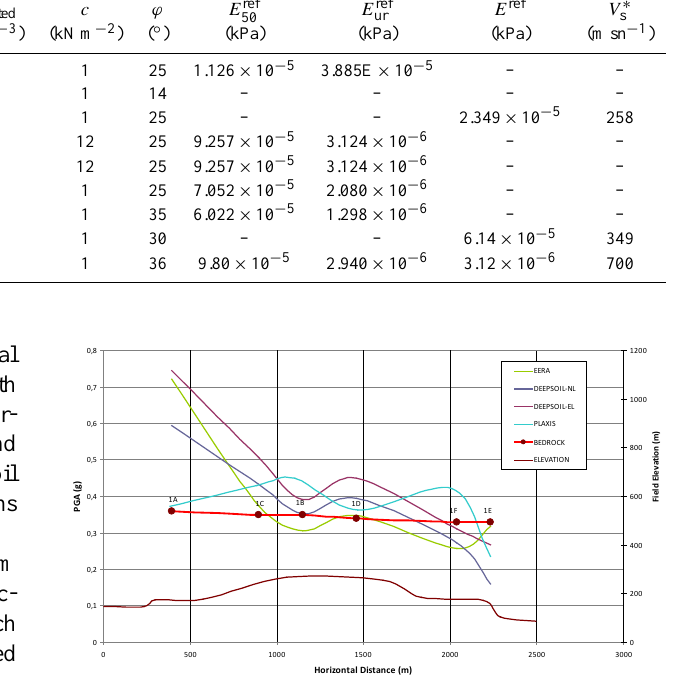
Figure 10. Change in the peak ground acceleration on the surface for the 1-1’ section The results of the one-dimensional analysis show a descending tendency between points 1A and 1C where the fill layer that was 14 m at the beginning gave way to a thick clay layer reaching 40 m. In the two-dimensional analysis, an increase in the acceleration value was observed upwards from the slope. Here, it could be thought that the changing topography appeared in the two–dimensional analysis. The decrease in the clay layer of about 10 m between the points of 1B and 1D (between two